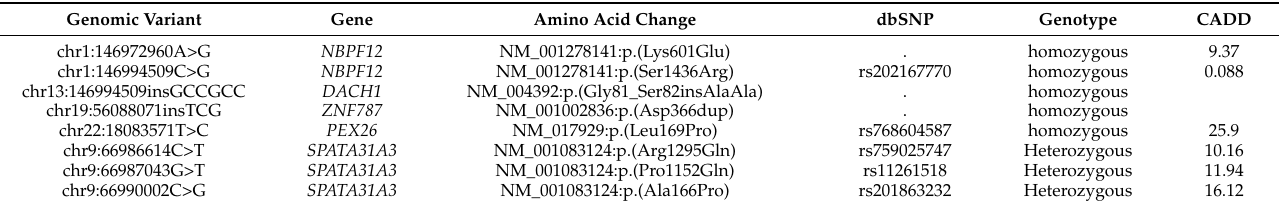
Table 2. Filtered sequence